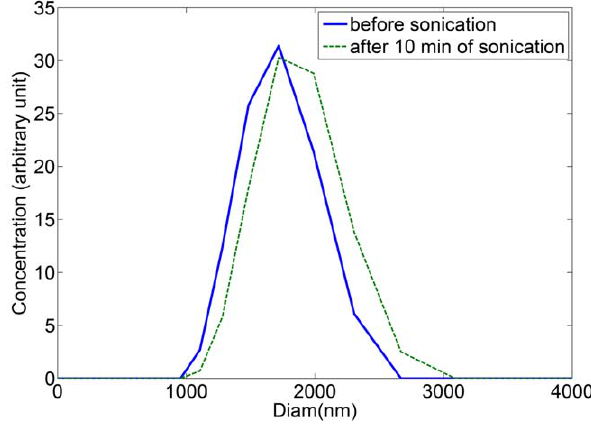
Figure 1. PolyQ41 Fibrils size distribution before (blue plain line) and after (dashed green) 10 min of sonication. The absence of any change in the distribution shows that neither fragmentation nor coalescence